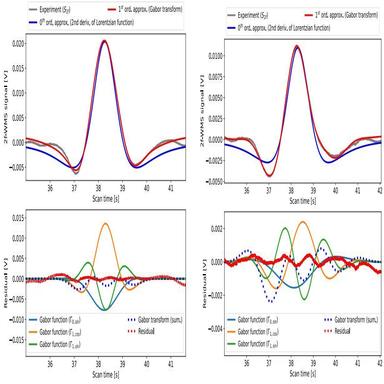
Experimental data and results of denoising post-procedure (baseline correction followed by line-shape fitting based on the set of Gabor functions) for Scenario C at different oxygen concentration levels: 50 % air + 50 % CO2 (left panels); 25 % air + 75 % CO2 (right panels). Residual of the Gabor transform is depicted in red (dotted line). Blue dotted line represents the product of selected envelope function (Gausian profile) and a sum of three goniometric (sine and cosine) functions (depicted as turquoise,